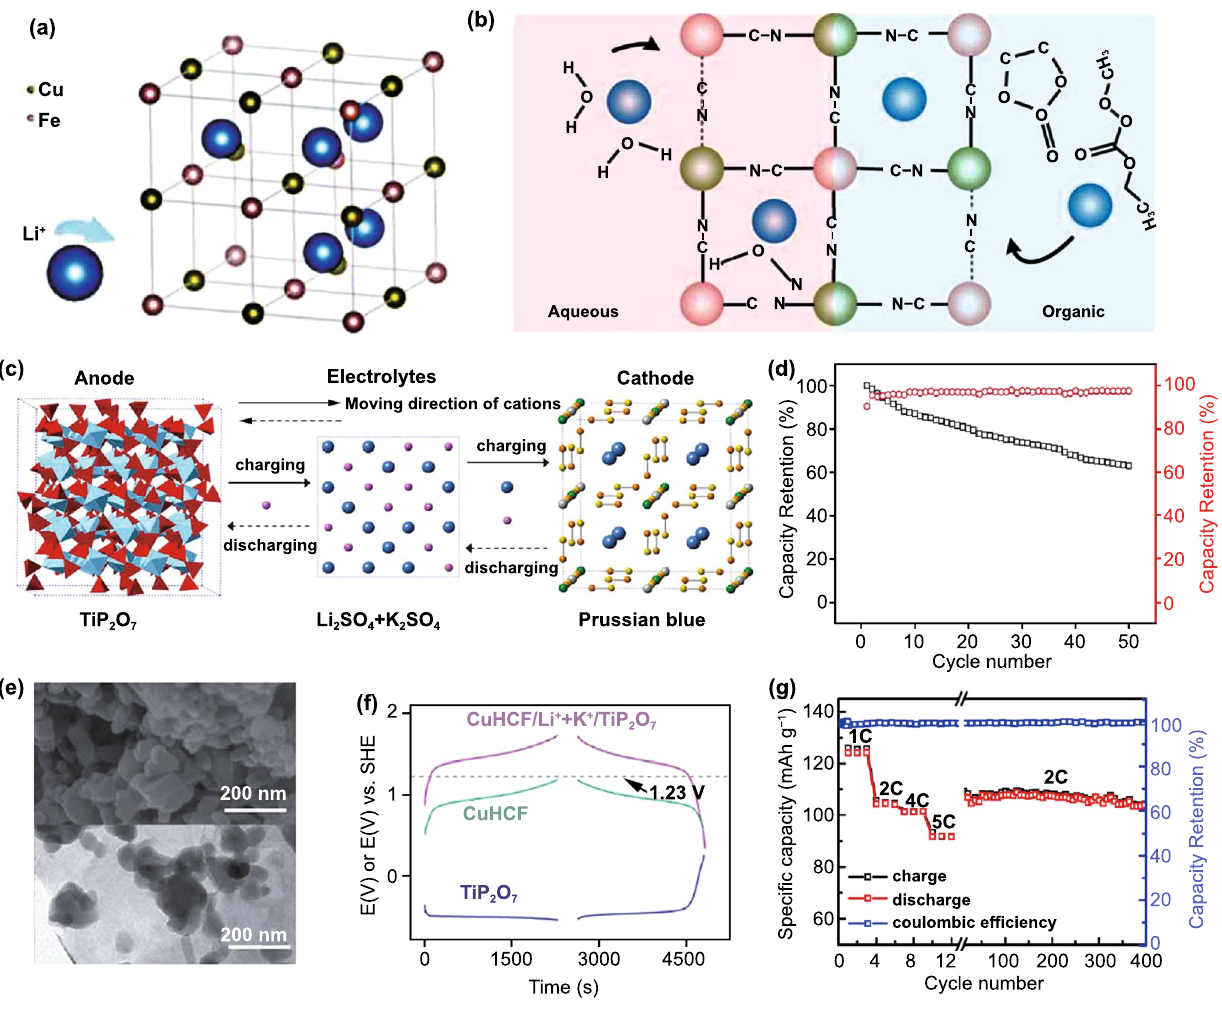
Fig. 8 a Crystal structure of copper hexacyanoferrate. b Schematic of Li + intercalation in copper hexacyanoferrate. Reproduced with per- mission from Ref. [88]. Copyright 2019, Electrochemical Society. c A schematic of K 0.08 Ni 0.75 Zn 0.70 Fe(CN) 6 /TiP 2 O 7 battery. d Cycle life of K 0.08 Ni 0.75 Zn 0.70 Fe(CN) 6 /TiP 2 O 7 battery at 1 C. Reproduced with permission from Ref. [108]. Copyright 2014, Wiley–VCH. e SEM and TEM images of K 0.04 Cu 1.47 Fe(CN) 6 . f Galvanostatic profiles of K 0.04 Cu 1.47 Fe(CN) 6 /TiP 2 O 7 with co-insertion of Li + and K + . Reproduced with permis- sion from Ref. [109]. Copyright 2017, The Royal Society of Chemistry. g Rate capability and cycling stability of Fe 4 [Fe(CN) 6 ] 3 /TiP 2 O 7 full cell. Reproduced with permission from Ref. [110]. Copyright 2013, American Chemical